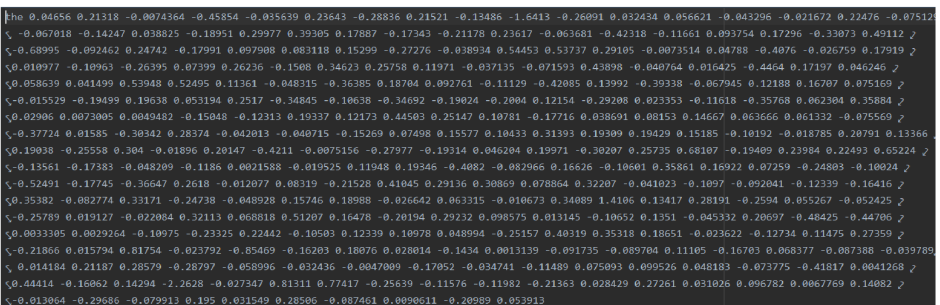
Fig. 8 Schematic diagram of text data processing.